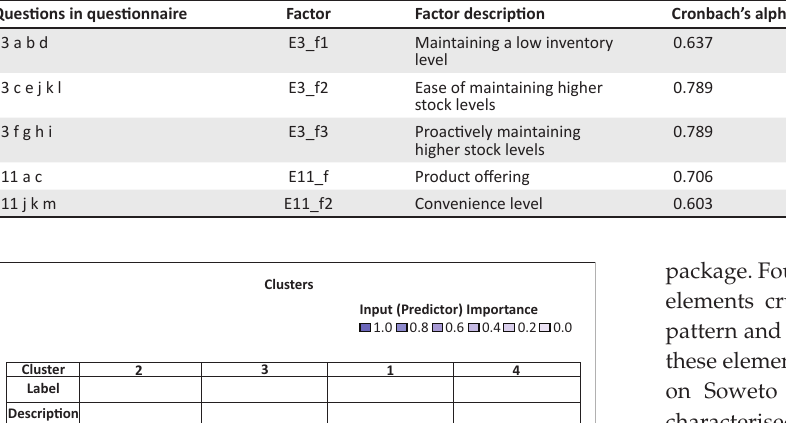
TABLE 2: Results of the factor analysis, reliability and descriptive statistics. Questions in questionnaire